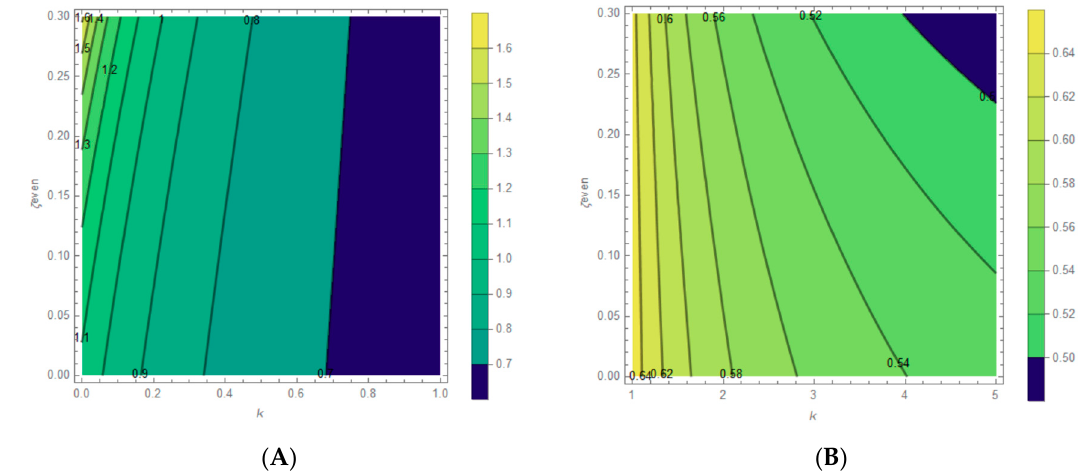
Figure 7. Simply-supported porous FG nano-beams: frequency ratio in terms of porosity volume fraction ( ζ ) and gradient index ( k ) with A w = 0.2, A 0 = 0.0 and (cid:101) K w = 0: ( A ) even distribution of porosity and k < 1, and ( B ) even distribution of porosity and k > 1.